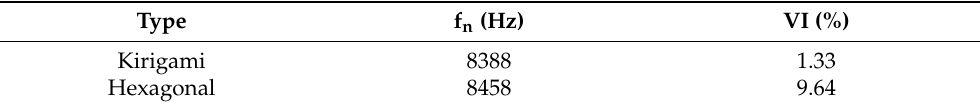
Table 3. Normalized voltage output of the two proposed auxetic MPS models: kirigami and hexago- nal.